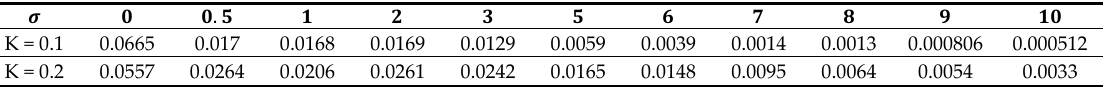
Table 2. Transfer entropy values with different noise intensity as (cid:2026) is